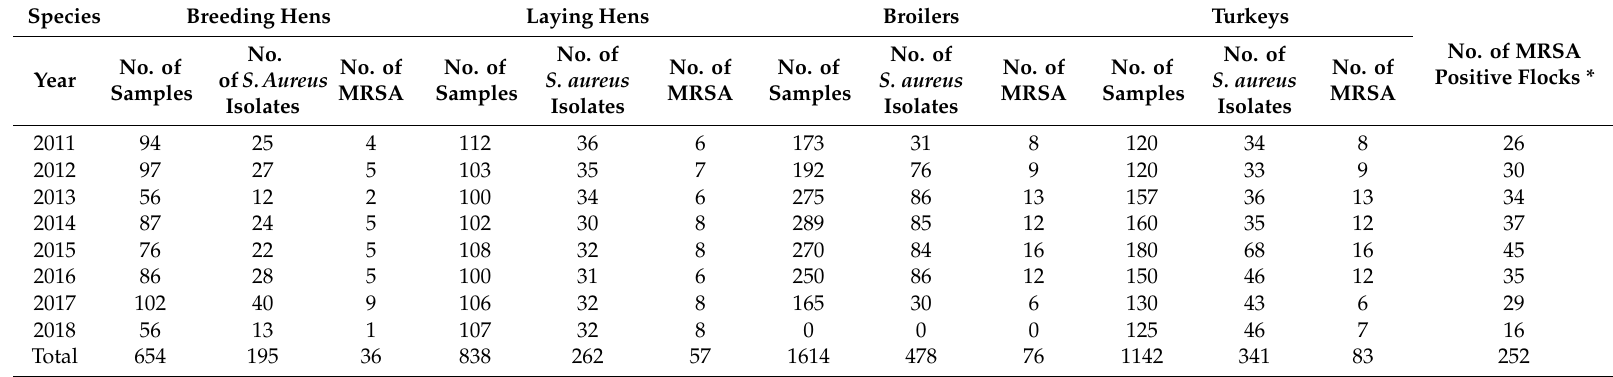
Positive Flocks *Year No. of